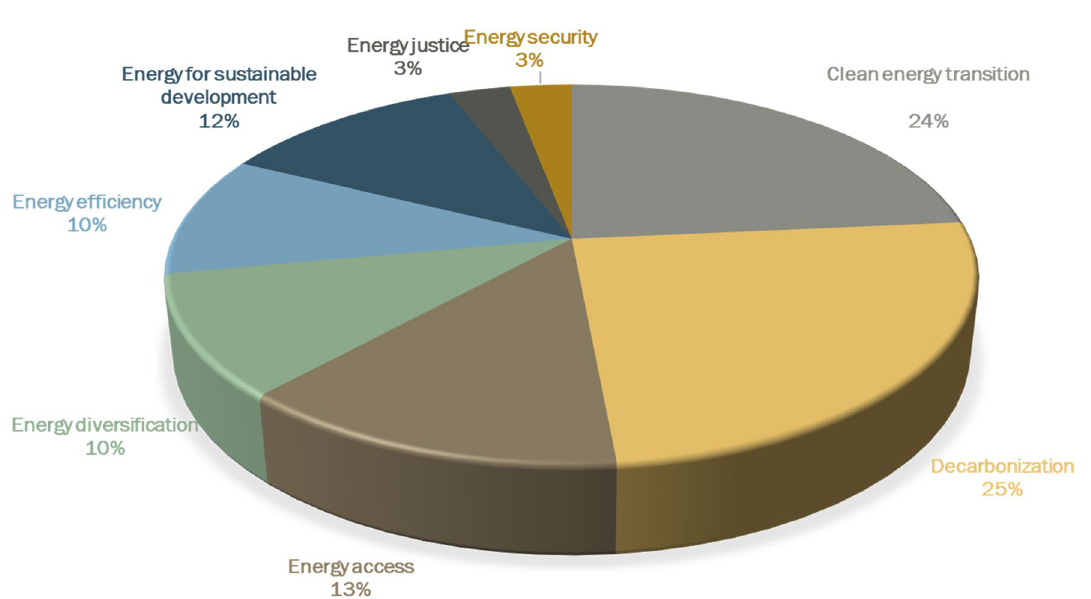
Fig. 9 Key drivers of energy policies for SDGs. Source: